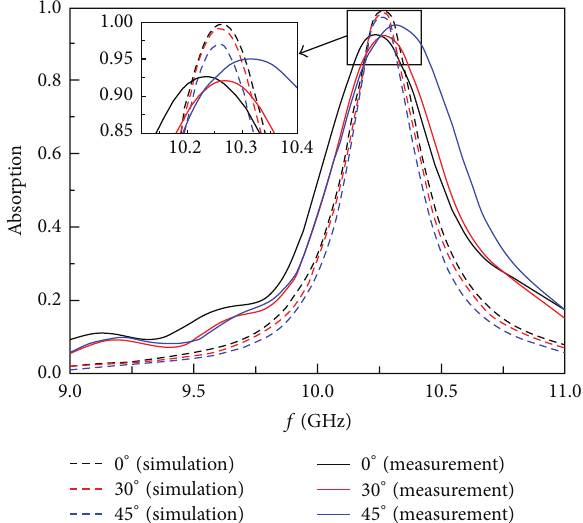
Figure 7: Simulated and measured absorptions at different angles (0, 30, and 45